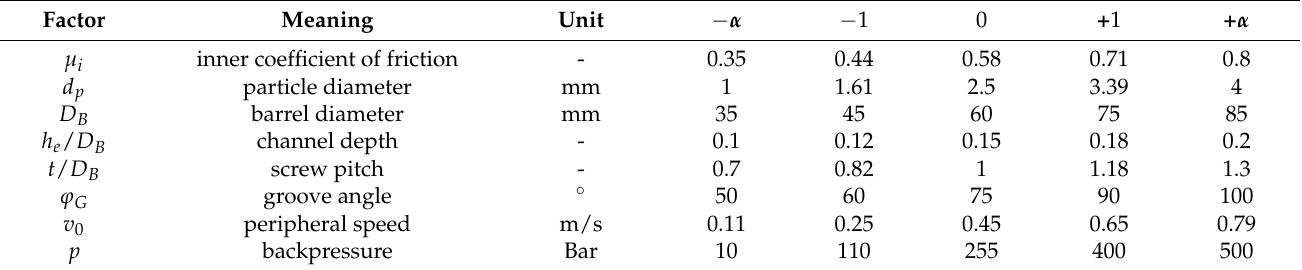
Table 1. Factors and step values of central composite